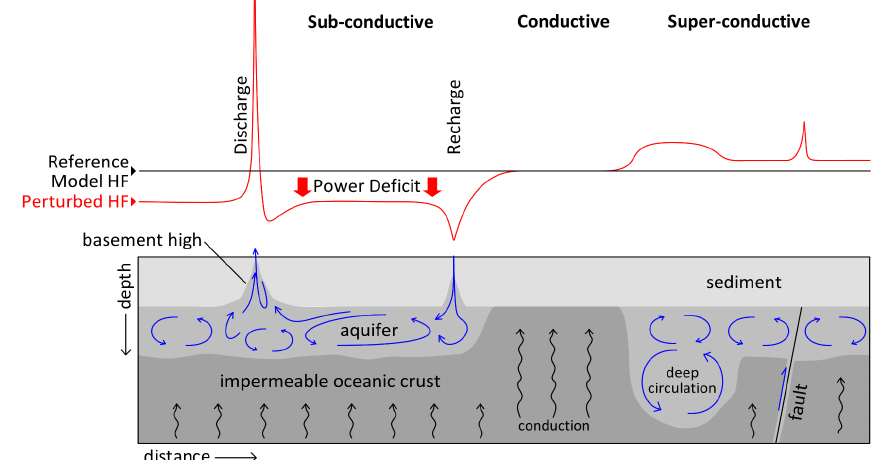
Figure 1. Figure showing the relationship between hydrothermal circulation patterns in the crust and resulting heat flow measured at the surface. Ventilation results in a net reduction in seafloor heat flux (sub-conductive heat flow), and vigorous hydrothermal circulation without ventilation results in a higher measured heat flux (super-conductive heat flow). The black squiggly lines indicate conductive heat transport, and the blue convection lines indicate hydrothermal patterns. The sites of recharge and discharge are located at basement highs in these